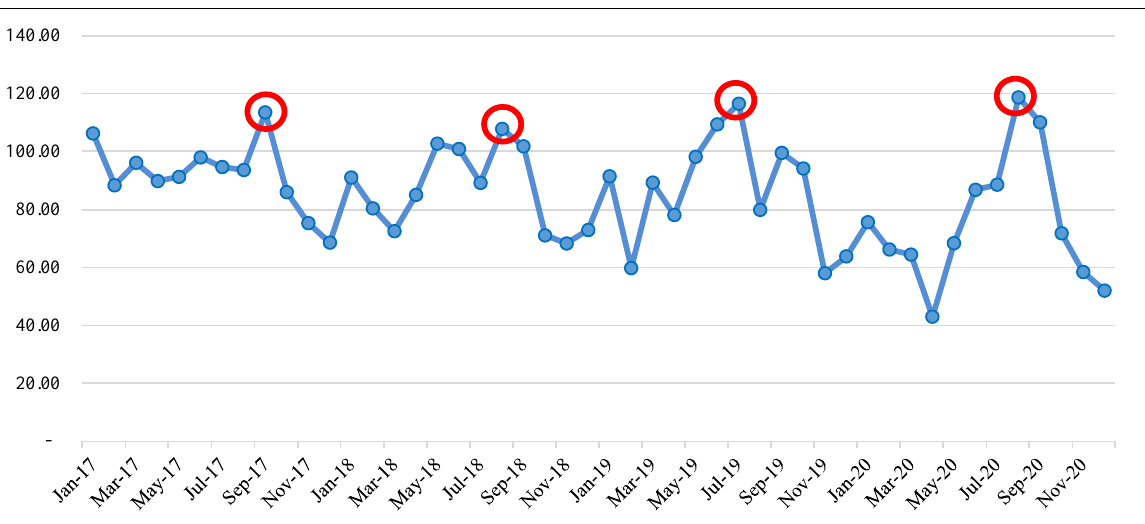
Figure 3. The rate of food poisoning incidence per 100,000 elderly people in Maha Sarakham Province at 4 epidemic peaks selected for the model analyses.